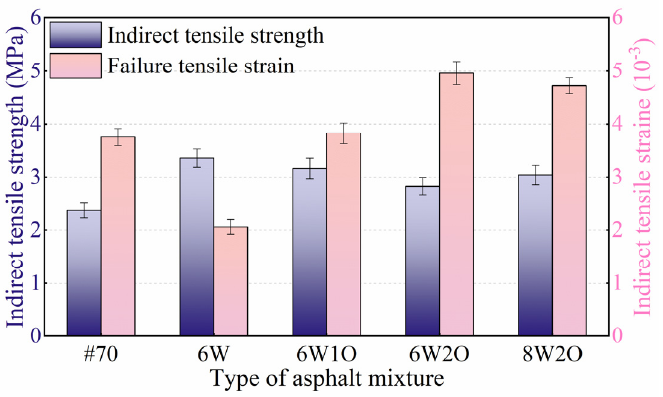
Figure 6. Test results of low-temperature indirect tensile strength and